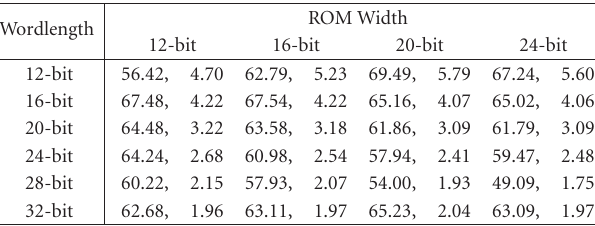
Table 3: Maximum clock rates and corresponding sampling rates of 88-section cochlea implementations of di ff erent wordlengths and ROM width (maximum clock rate (MHz) and maximum sampling rate